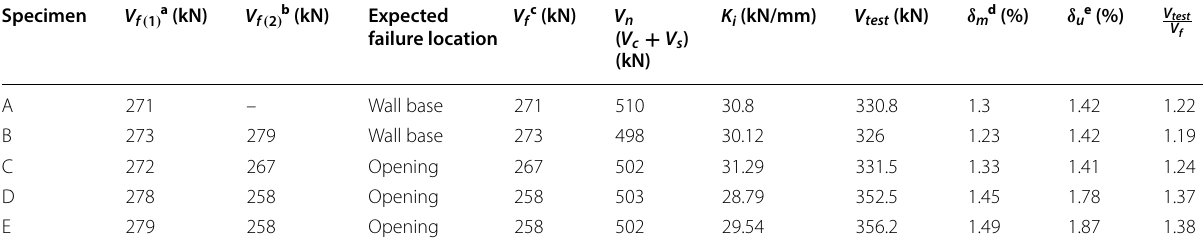
Table 3 Test results.